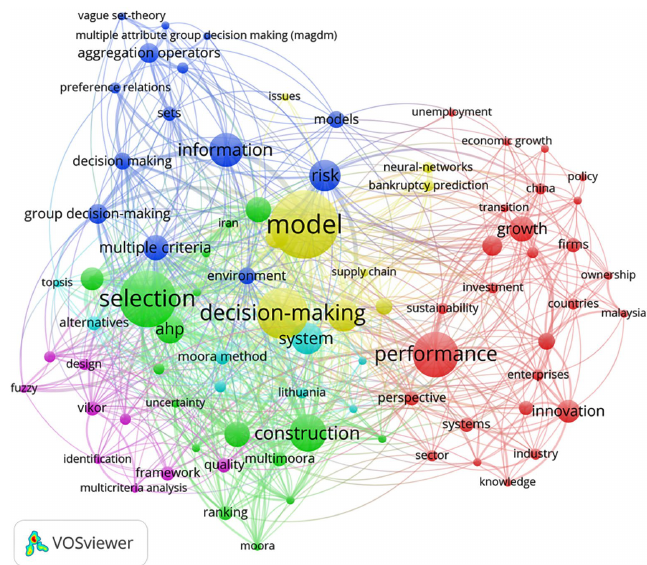
Figure 4. Co-occurrence network of keywords of the TEDE publications, 2011–2014